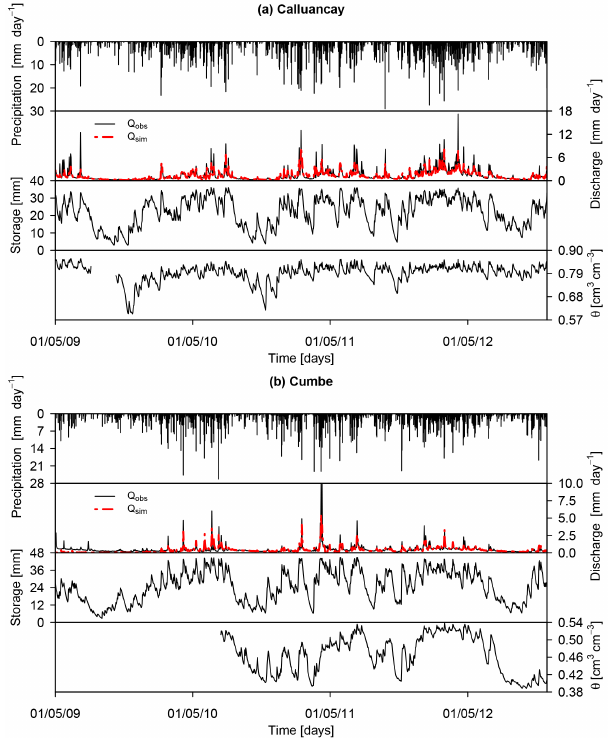
Figure 4. Results from the hydrological modelling with the PDM model. From the top for each figure: panel 1 – precipitation; panel 2 – observed ( Q obs ) and simulated ( Q sim ) river discharge; panel 3 – simulated average soil water storage; panel 4 – soil moisture measured in an experimental